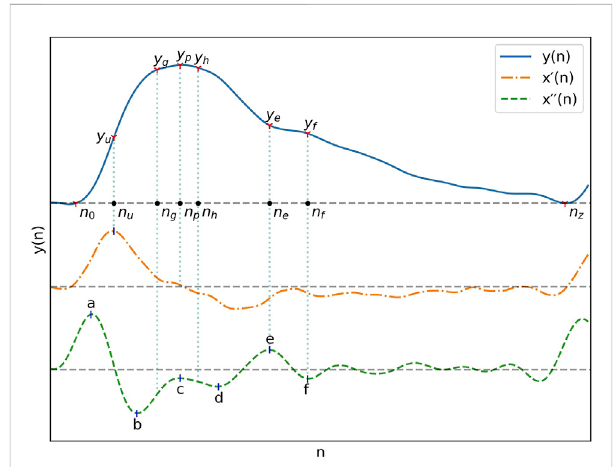
FIGURE 1 A typical PPG signal as well as its fi rst and second derivatives with their most important fi ducial